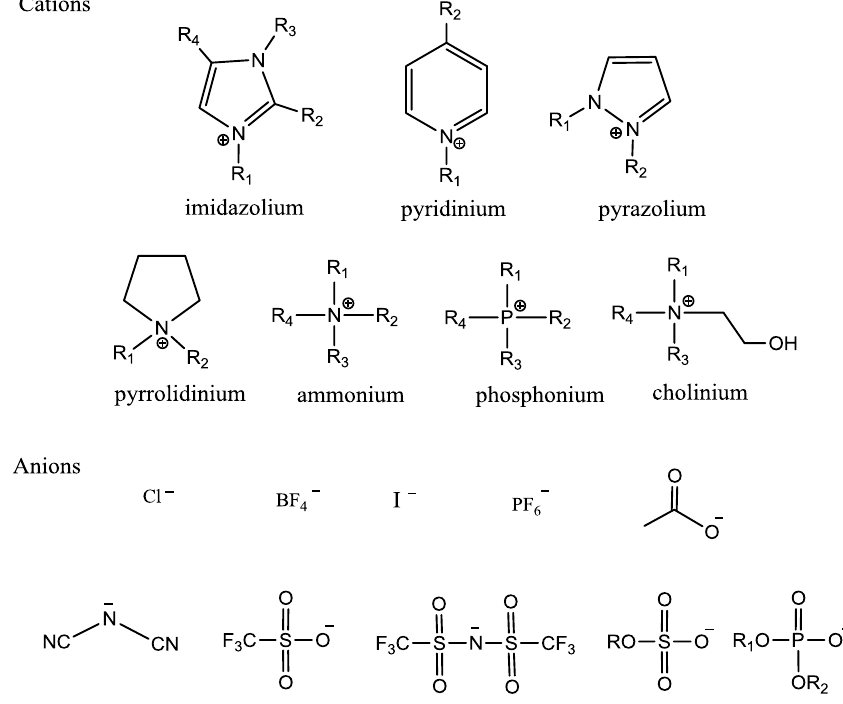
Figure 1. Main cations and anions described in